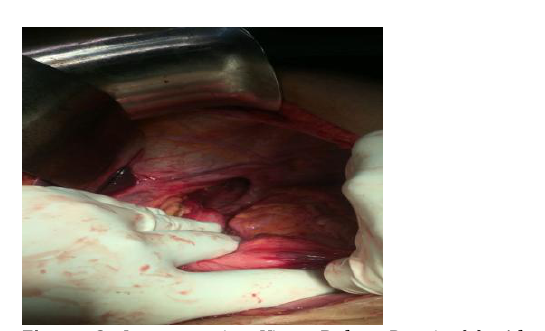
Figure 3. Intraoperative View: Before Repair (a); After Repair (b)